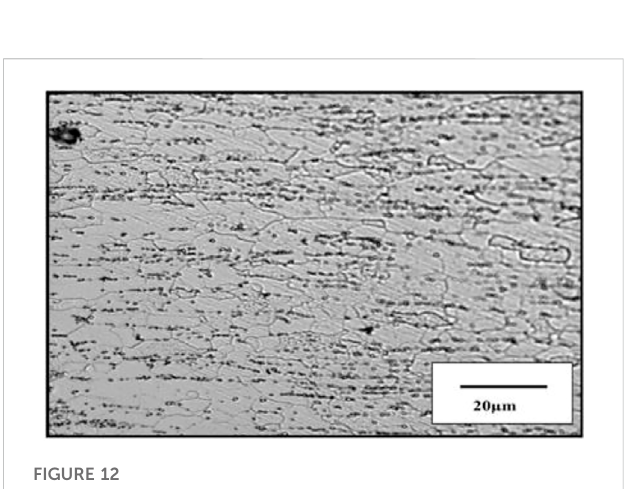
FIGURE 12 Optical micrographs of cross-sectional substrate steel.